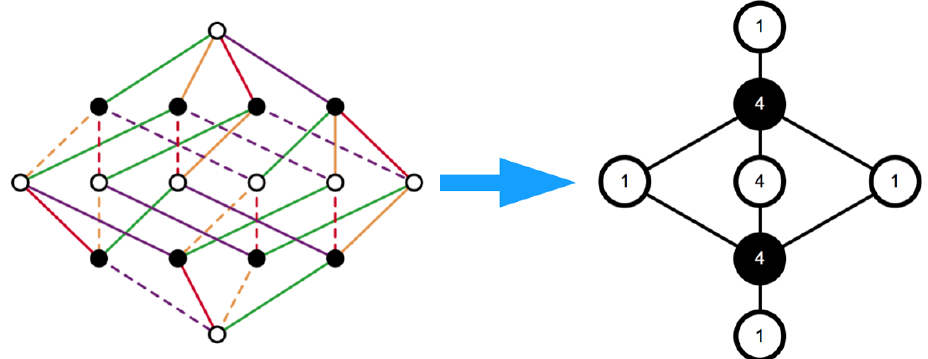
Figure 3 . From 1D, N = 4 adinkra to 4D, N = 1